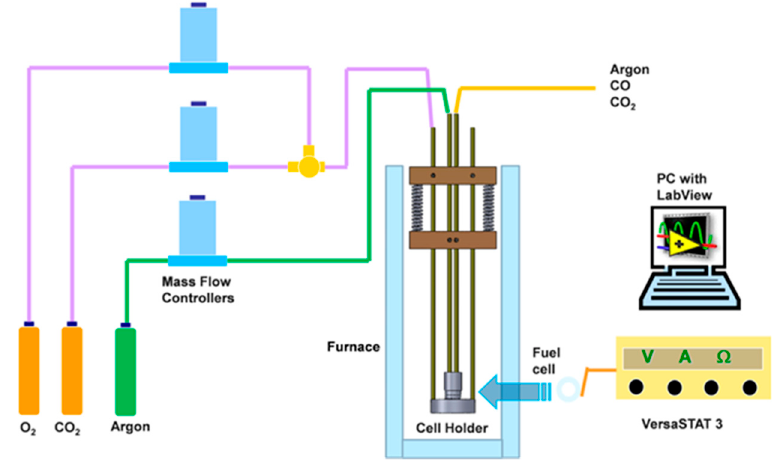
Figure 3. Operation mode of the DCFC.